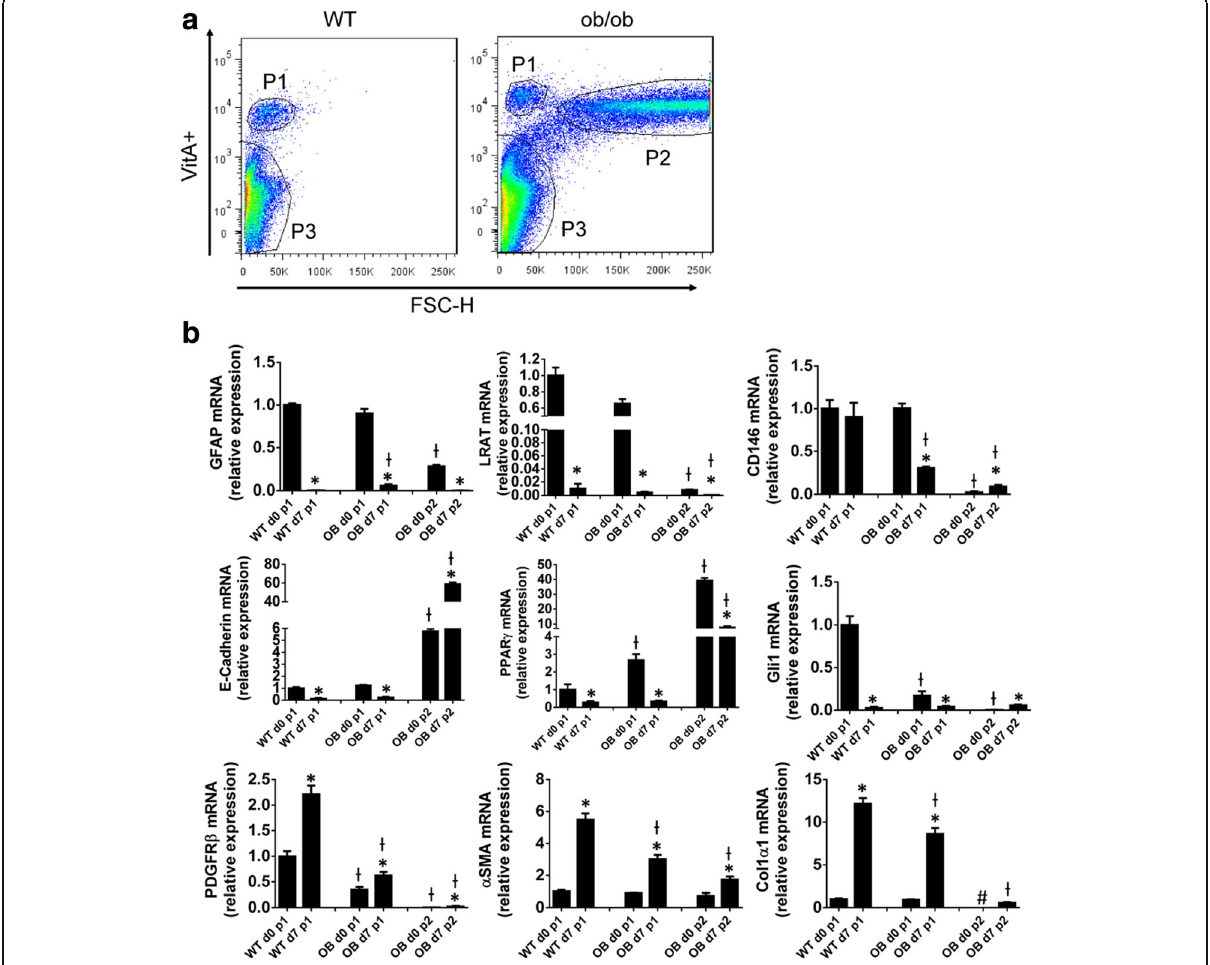
Fig. 3 Leptin Deficiency Alters HSCs That Are Purified by Retinoid-based FACS Isolation. a Ultrapure HSCs were obtained by retinoid-based FACS of Nycodenz-gradient purified HSCs from WT and ob/ob mice. P1 population contains ultrapure HSCs, P2 population contains high side scatter (i.e., large), retinoid-high cells and only exists in ob/ob HSC prep, and P3 population contains cell debris and dead cells (which are removed via a 2 h cell adherence step in our standard HSC preps) ( b ) RNA was isolated from both freshly FACS sorted P1 or P2 cells (d0) or 7 day cultured FACS-sorted cells (d7), and gene expression profiles were examined by qRT-PCR. Ɨ p < 0.05 vs WT, * p < 0.05 vs d0. #